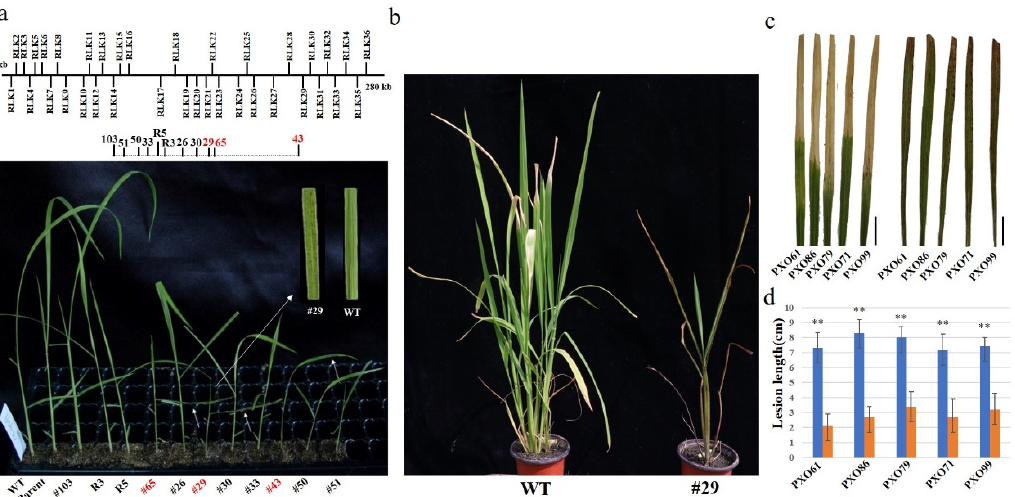
Figure 2. The #29 mutant plants have broad resistance to Xoo . ( a ) The #29 mutant was generated by the Ac/Ds system. WT, wild-type plants (Dongjin). ( b ) The #29 mutant and wild-type plant (Dongjin). ( c ) The leaves of #29 and wild-type plant after inoculation with Xoo strains (PXO61, PXO86, PXO79, PXO71 and PXO99). ( d ) Lesion length of wild-type plant and the #29 mutant after inoculation of Xoo strains (PXO61, PXO86, PXO79, PXO71 and PXO99). The lesion length in wild-type and the #29 plants was calculated. Data indicates average ± standard error (SE) ( n > 6). **, p < 0.01.